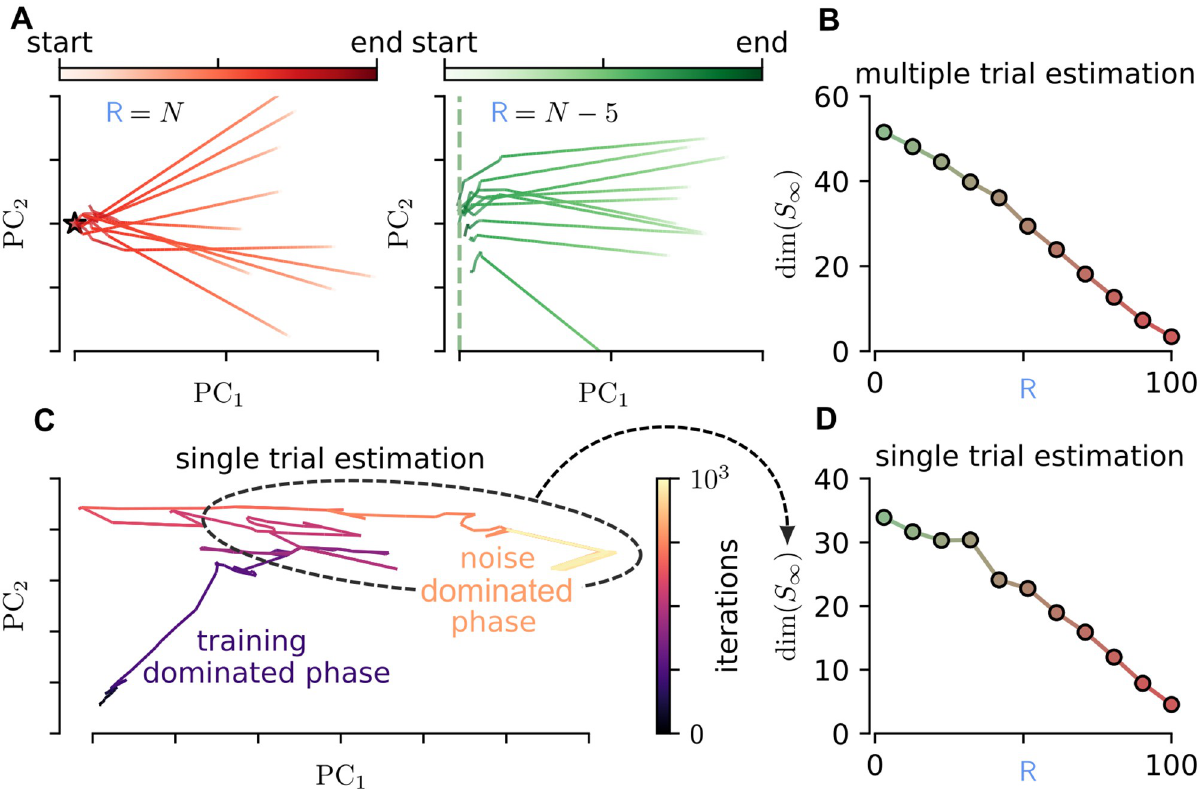
P ¼ j s ? t (cid:0) s t j in the first two i t i i as a P 1 ¼ j s 1 t (cid:0) s t j in the first two principal i i i t